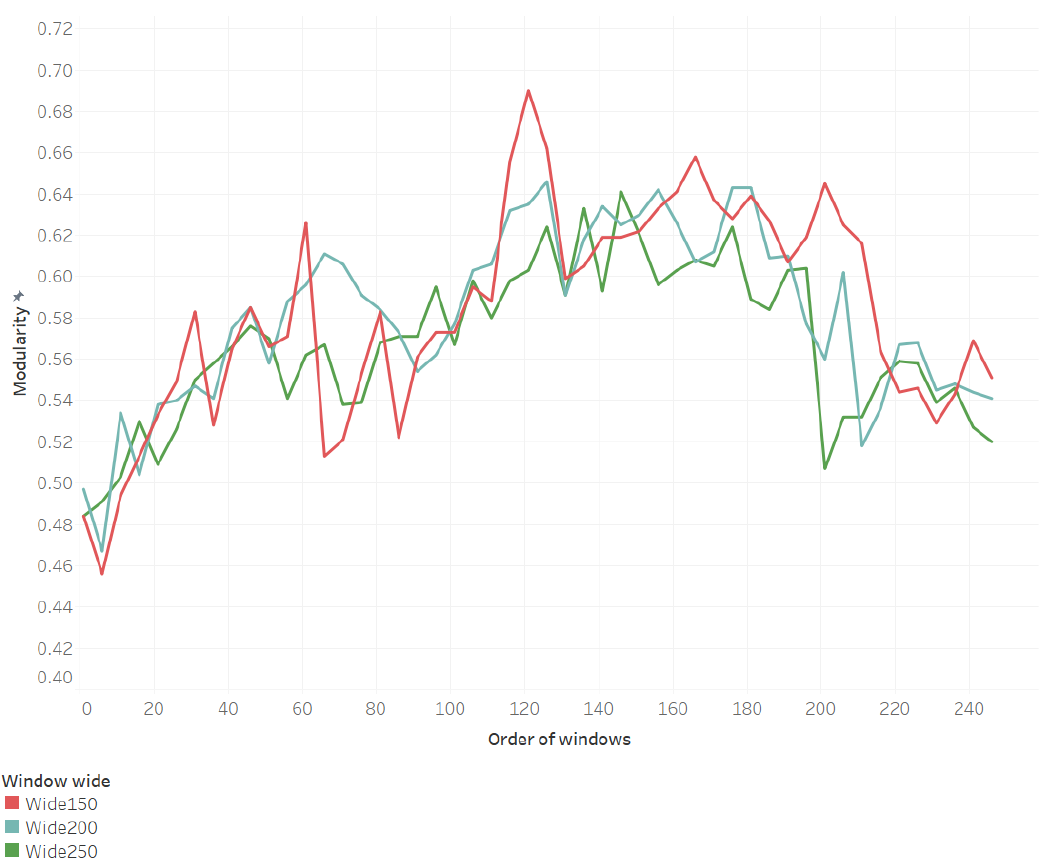
Figure 5. Trends of network modularity based on different window widths. Note: The number in the X -axis is the order of the sampling windows, which increases as the total index increases.